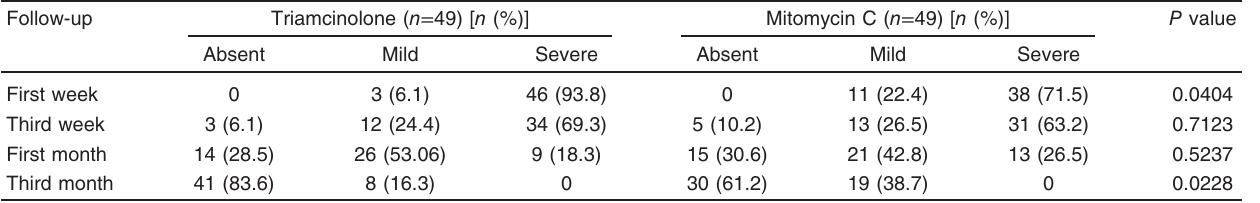
Table 3 Crusting during follow-up Follow-up